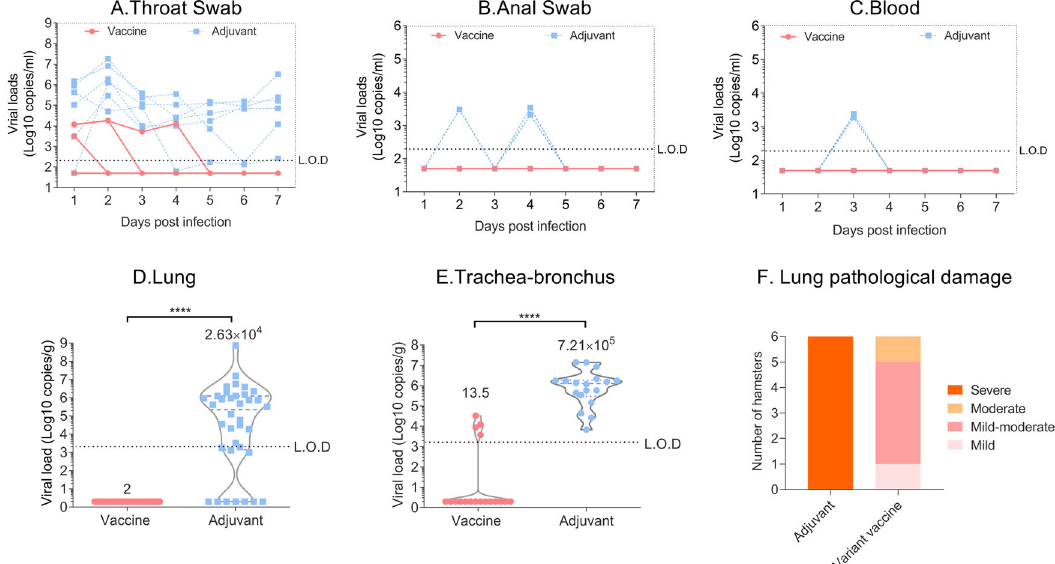
Fig. 8 Protective ef fi cacy and lung pathology against with prototye SARS -CoV-2 in rhesus macaques. The daily viral shedding of ( A ) throat swabs, ( B ) anal swabs and ( C ) blood samples infected with SARS CoV-2 prototype strain. The viral loads of lung ( D ) and trachea-bronchus ( E ) on the 7 day post the challenged, data were shown as the quartiles and median by violin plot (truncated). F Number of infected hamsters that displayed mild, moderate, mild-moderate or severe lung pathology in each group. Note: L.O.D Limit of Detection; Detection threshold: 1000 – 10000 copies/g, below the detection threshold, assign a value of “ 2 ” .